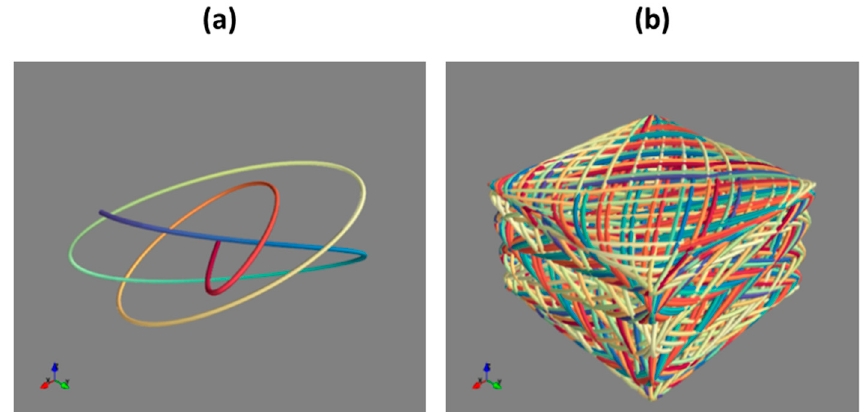
Figure 4. 3D Lissajous curve obtained for the oscillation frequencies at f x = 650 Hz and f z = 452 Hz with different scanning times: ( a ) t = 5 ms; and, ( b ) t = 200 ms (color of the curve corresponds to the time moment).